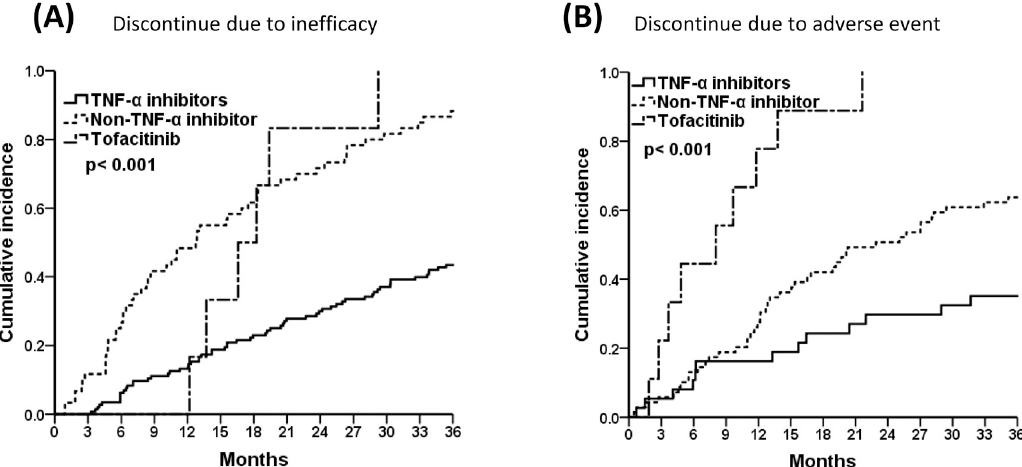
Fig 2. The 3-year cumulative incidences of TNF- α inhibitors, non-TNF- α inhibitors, and tofacitinib, (A) Discontinued due to inefficacy, and (B) Discontinued due to adverse event by Kaplan-Meier survival analysis. Pairwise comparison (A) TNF- α inhibitors vs. non-TNF- α inhibitors, p < 0.001; TNF- α inhibitors vs. tofacitinib, p = 0.001; non-TNF- α inhibitors vs. tofacitinib, p > 0.05, (B) TNF- α inhibitors vs. non-TNF- α inhibitors, p = 0.014; TNF- α inhibitors vs. tofacitinib & non-TNF- α inhibitors vs. tofacitinib, p < 0.001.